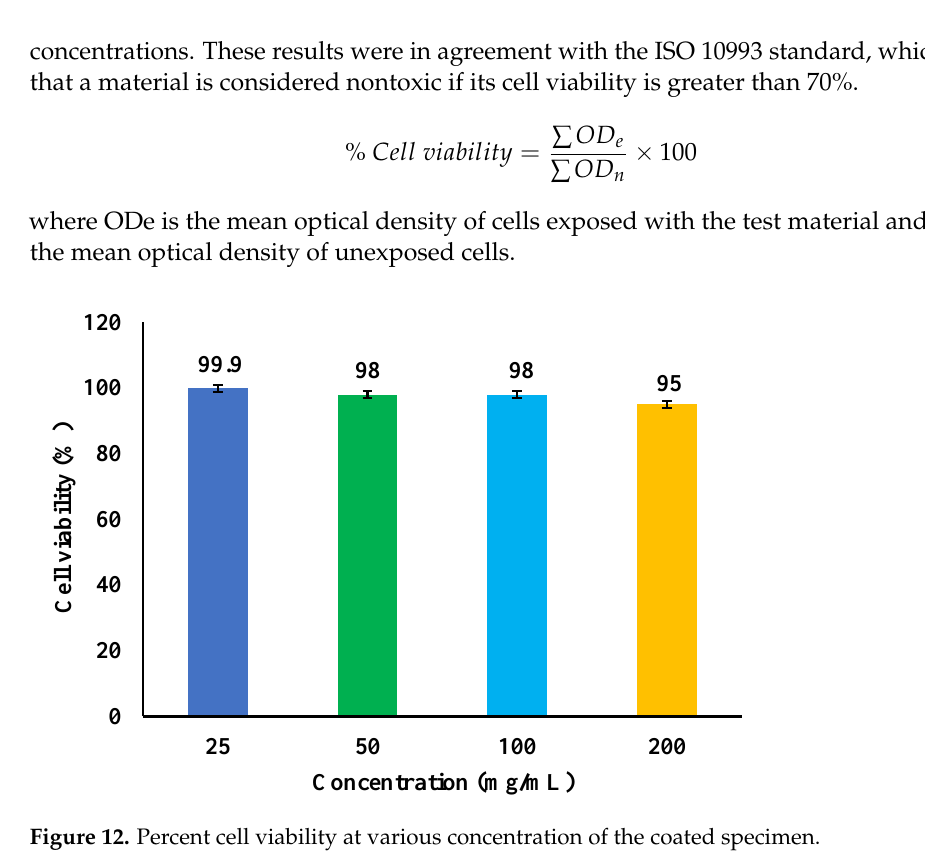
Table 6. OD and L929 cell viability values after 24 h of exposure to the positive control.